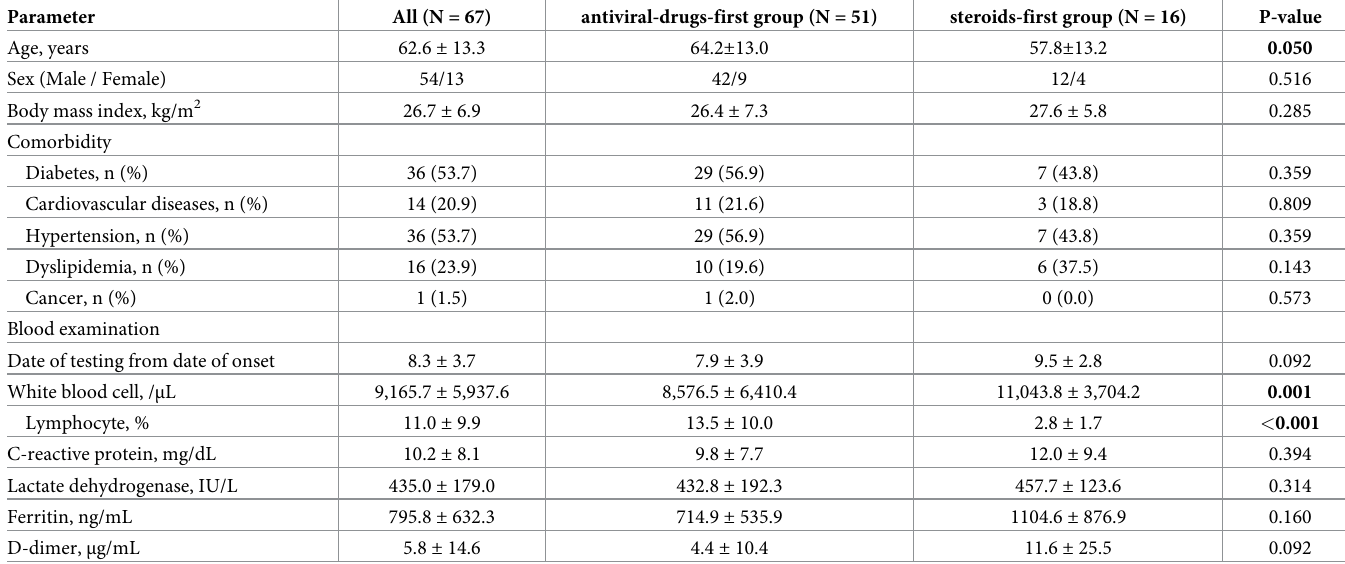
Table 1. Baseline characteristics (N = 67).